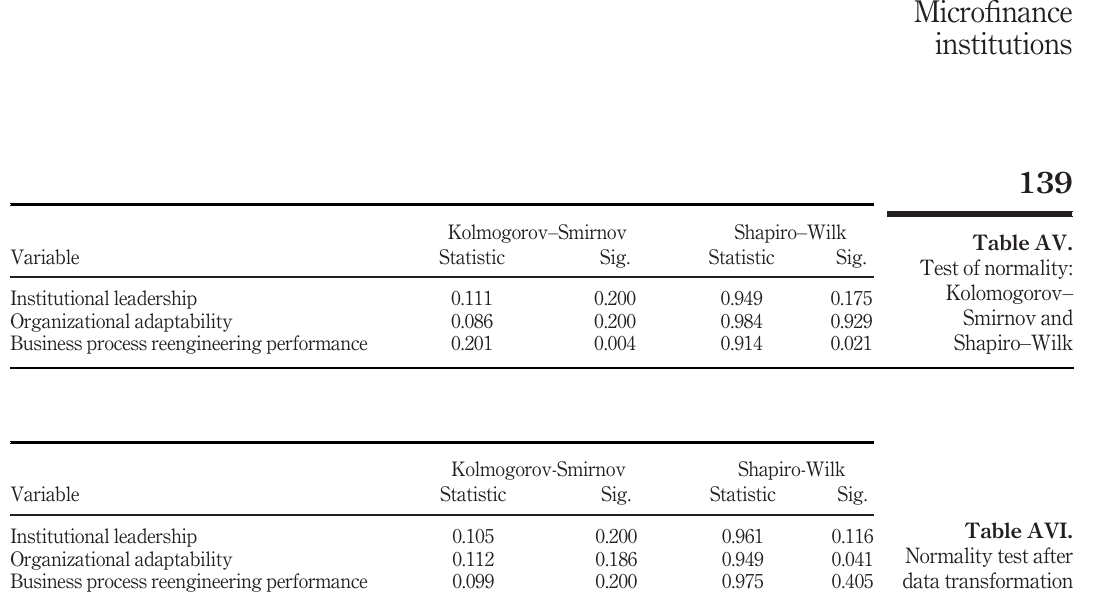
Table AVI. Normality test after